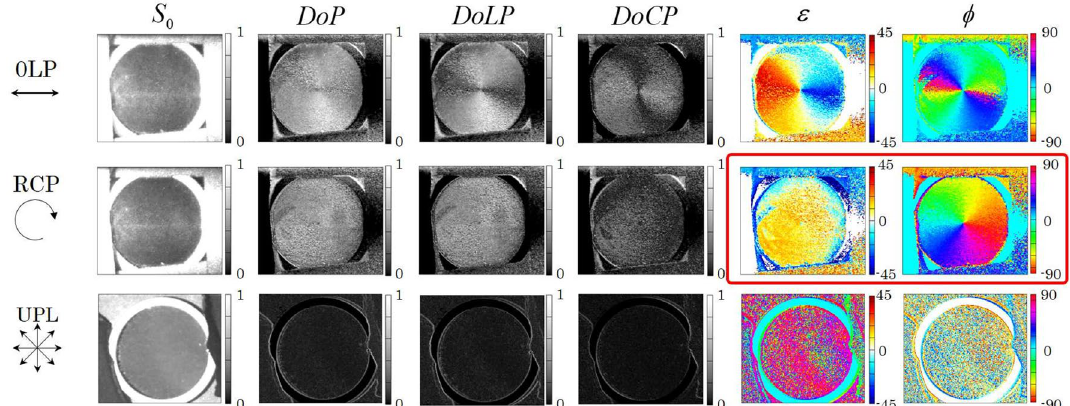
Figure 5. Intensity, degree of polarization, degree of linear polarization, degree of circular polarization, ellipticity angle, and azimuth angle properties calculated from the Stokes parameters of the patterned retarder obtained using the PPPI system.